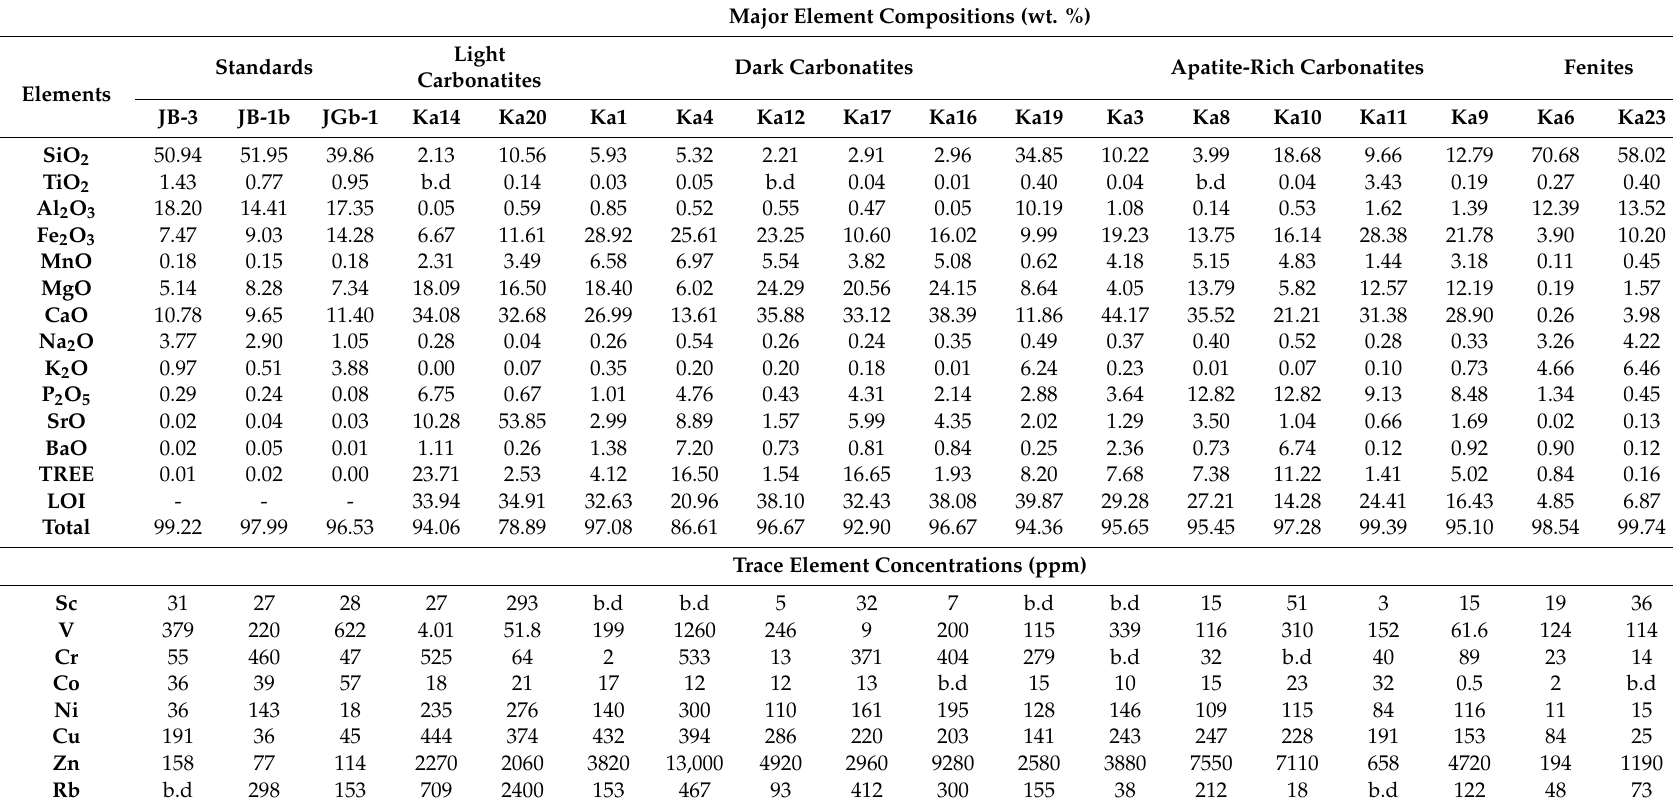
Table A1. Major- and trace-element compositions of the Kangankunde carbonatites and